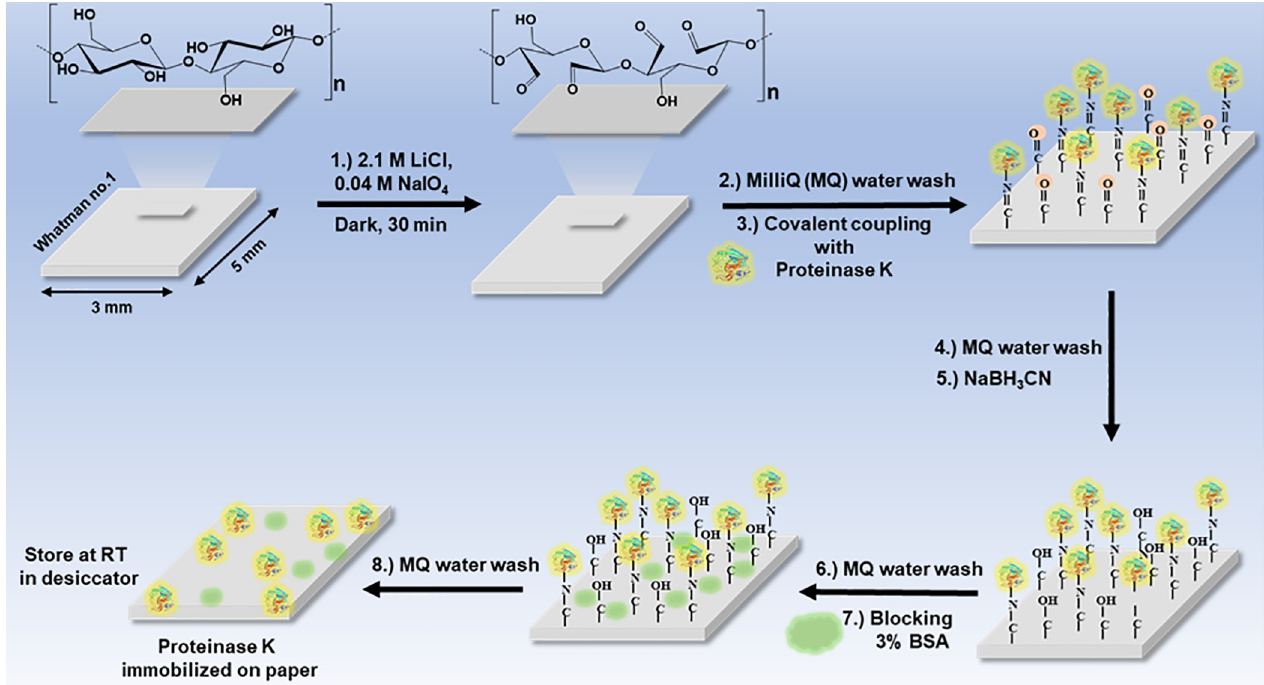
Fig 2. Scheme of immobilizing Proteinase K (IPK). Schematic representation of the immobilization of Proteinase K on Whatman paper # 1. Lithium chloride in the presence of sodium Periodate was used to change the functional group of the paper from hydroxyl to aldehyde group. Proteinase K was covalently immobilized on the charged paper and treated with sodium cyanoborohydride to preserve the covalent bonds, followed by blocking the non specific binding sites.